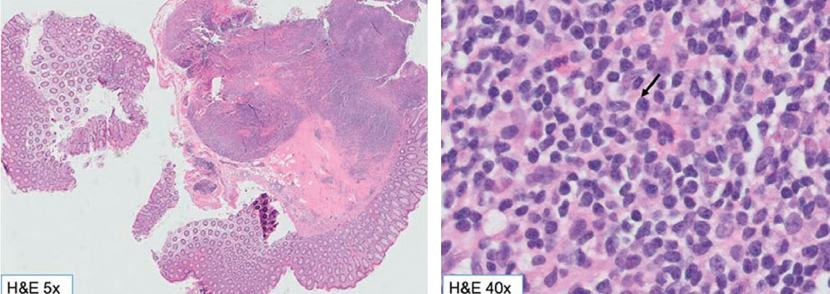
Figure 3: The H&E sections show proliferation of atypical lymphoid cells involving the colonic mucosa and submucosa, forming multifocal large lymphoid aggregates. H&E section on 40x shows lymphoid cells that are small in size and have scant to moderate cytoplasm. Admixed with them are scattered plasma cells